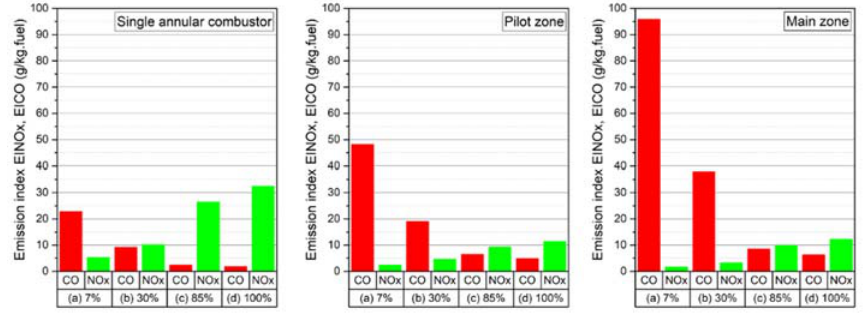
Figure 10. Emission indices of NO x and CO for each step in the LTO cycle. Table 8. Cases for reducing CO emission.